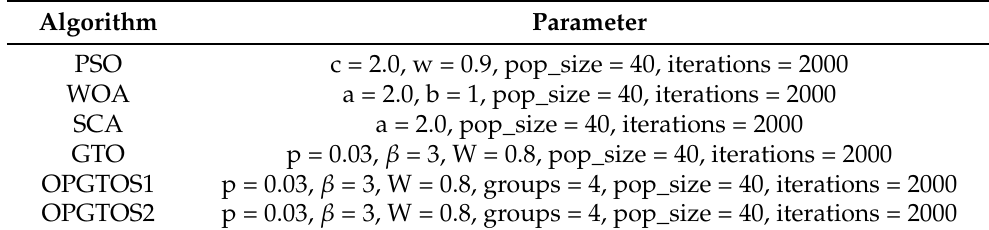
Table 1. Parameter settings for each algorithm.